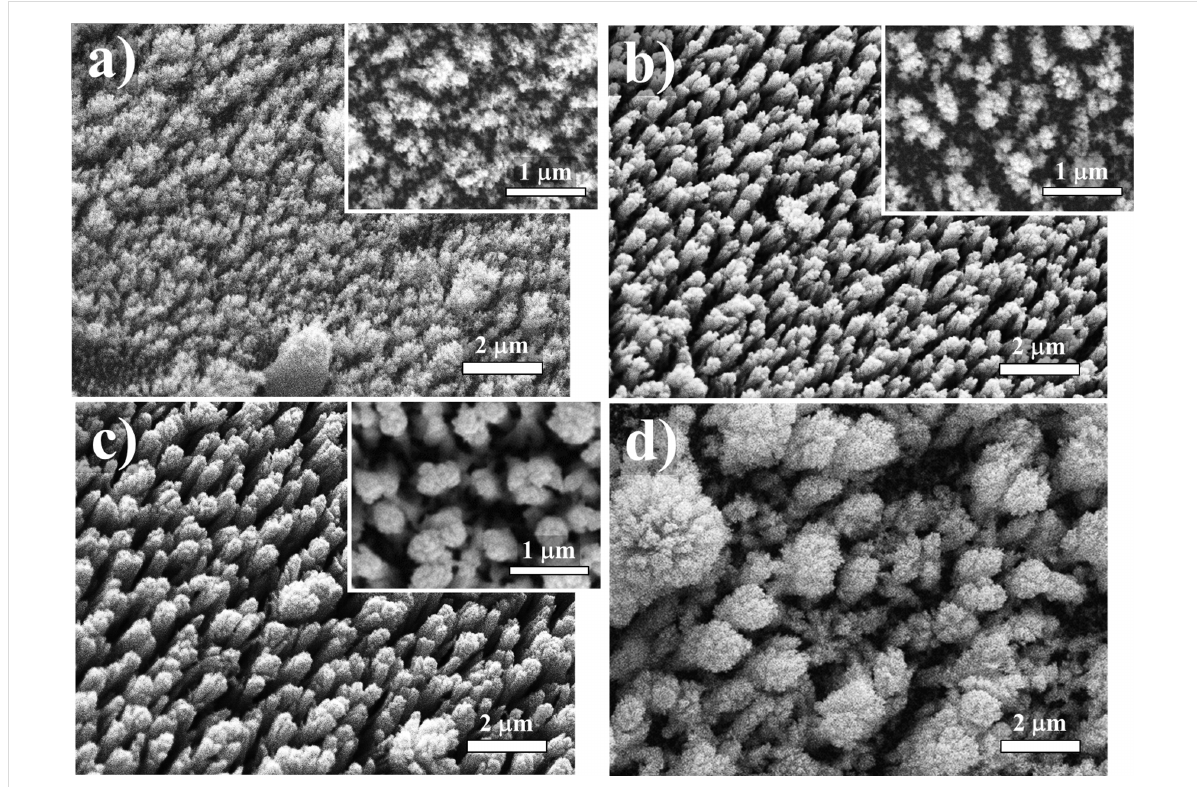
Figure 4: SEM images of the Au nanostructures deposited using (a) geometry 1, (b) geometry 2, (c) geometry 3, and (d) geometry 4. The insets show a top view of the structures.